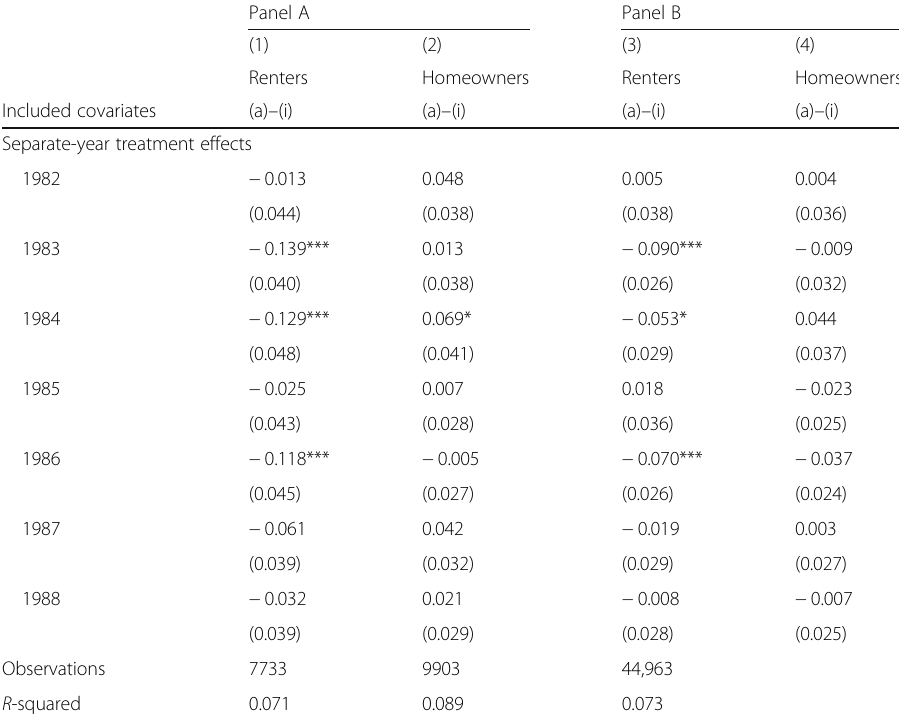
Table 5 Estimated impacts of Boatlift on fertility of women living in rented and in owned